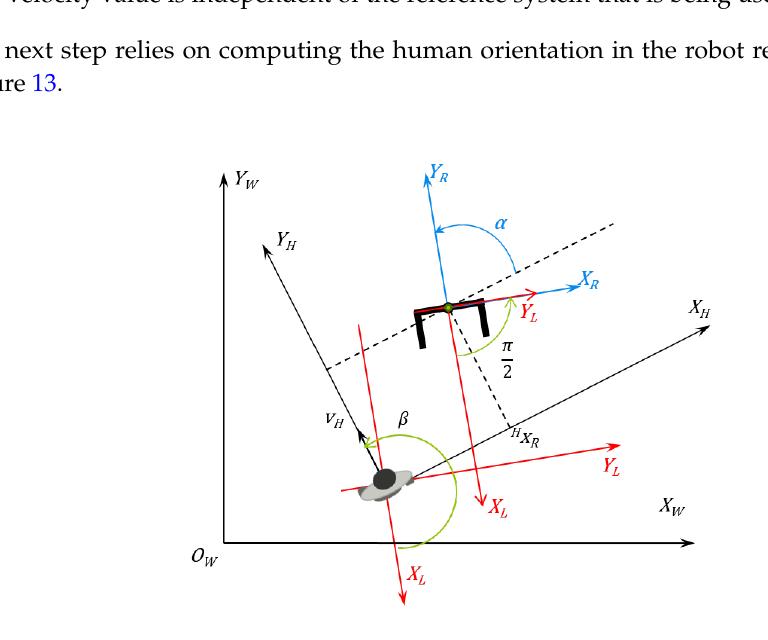
Figure 13. Calculation of the angle of the human in the laser